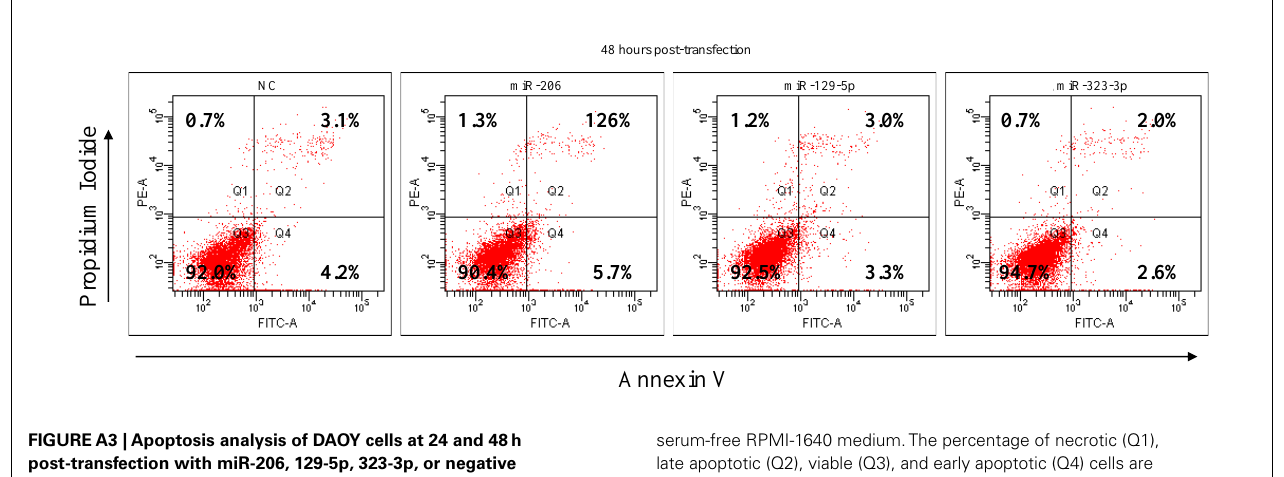
FIGUREA3 |Apoptosis analysis of DAOY cells at 24 and 48h post-transfection with miR-206, 129-5p, 323-3p, or negative control mimics, as evaluated byAnnexinV and propidium iodide staining and FACS analysis . DAOY cells grown in